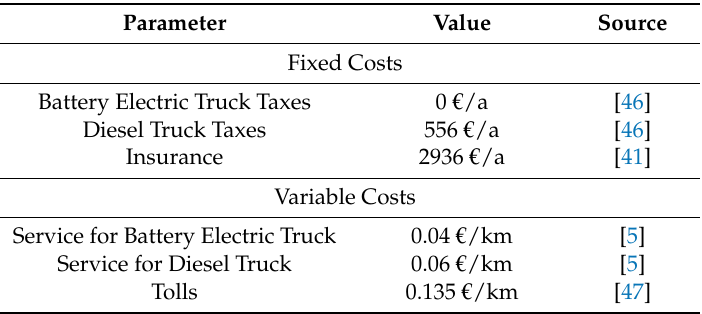
Table A4. Costs parameters for fixed and variable costs used in LCC